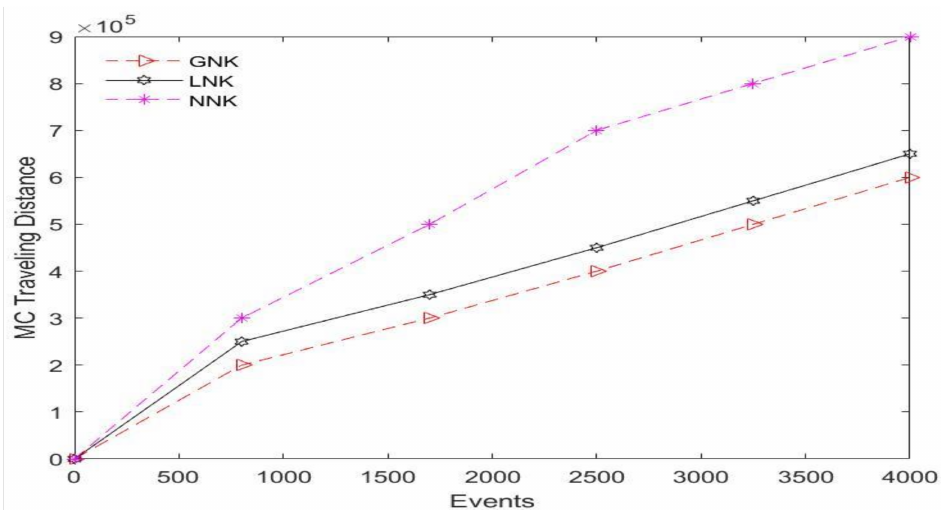
Figure 8. Distance travelled by MCs for uniform deployment.